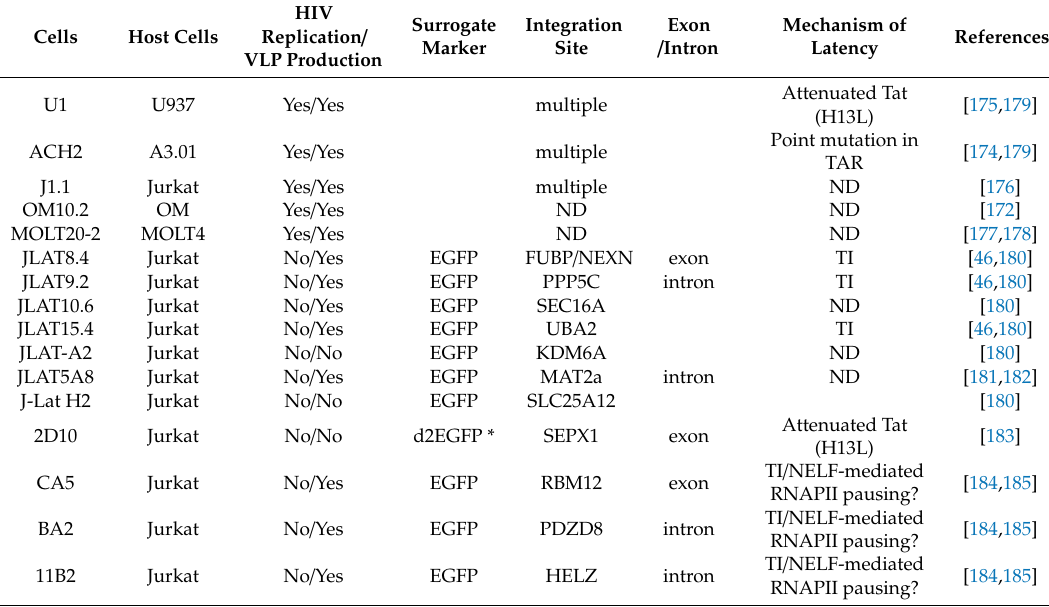
Table 2. Examples of HIV latency